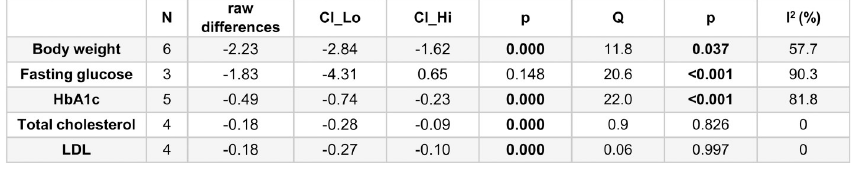
Fig 4. Summary data of outcome parameters.